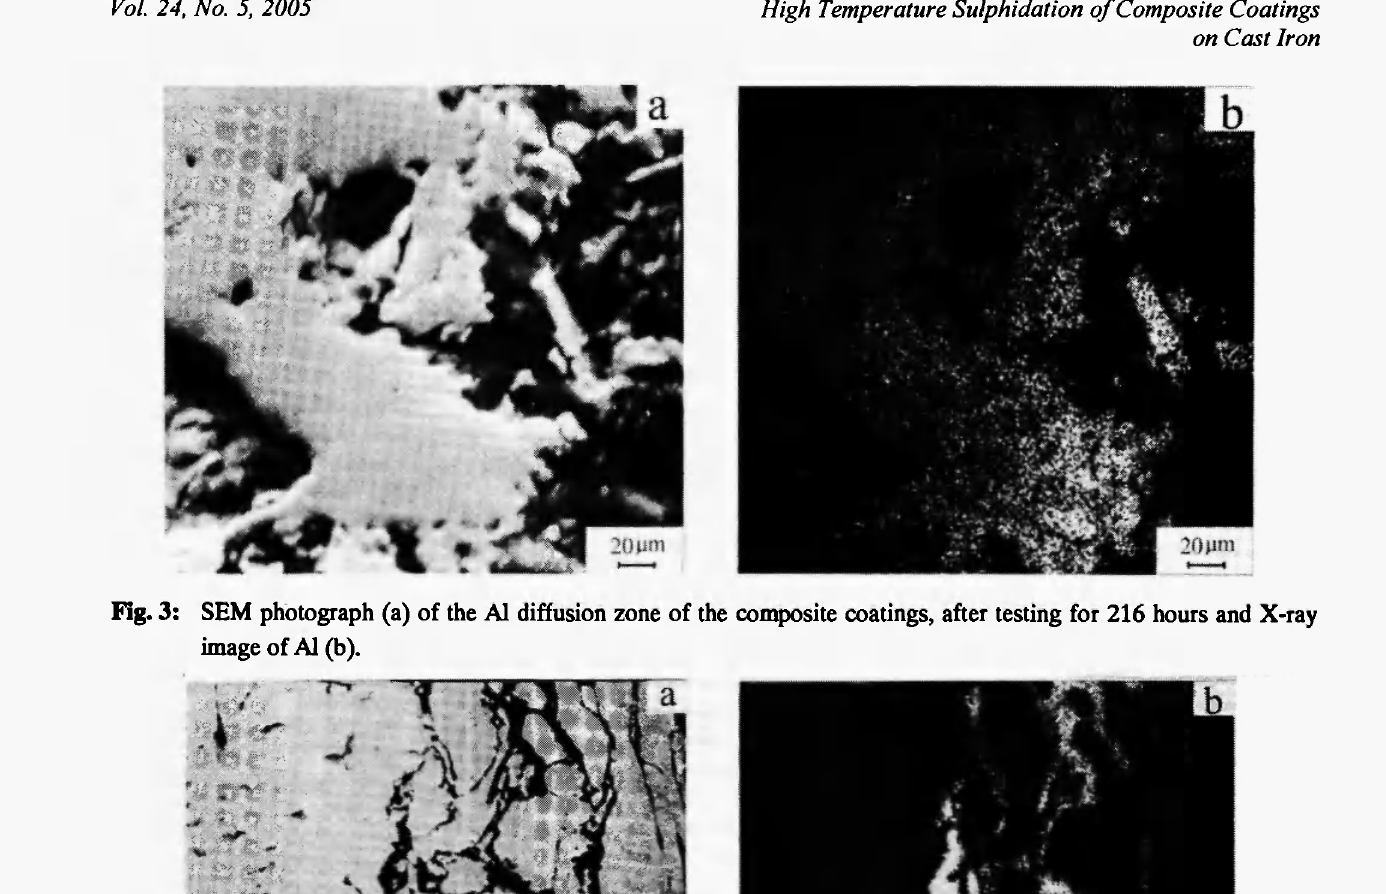
Fig. 3: SEM photograph (a) of the AI diffusion zone of the image of Al (b).